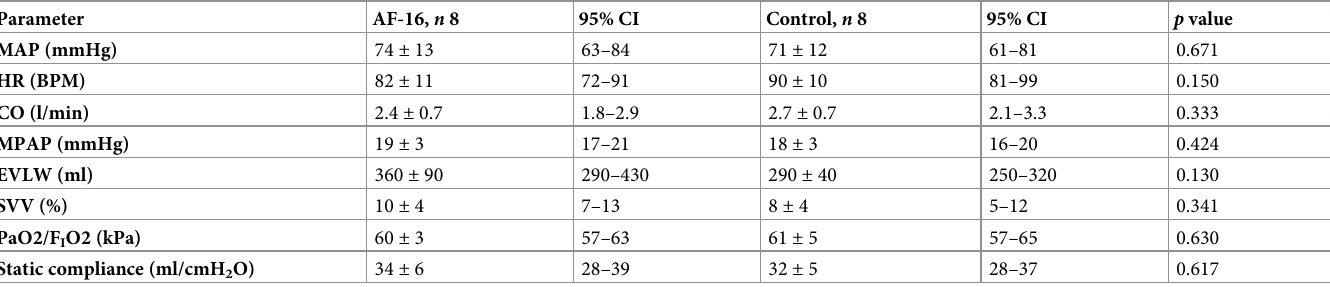
Table 1. Measurements at baseline.